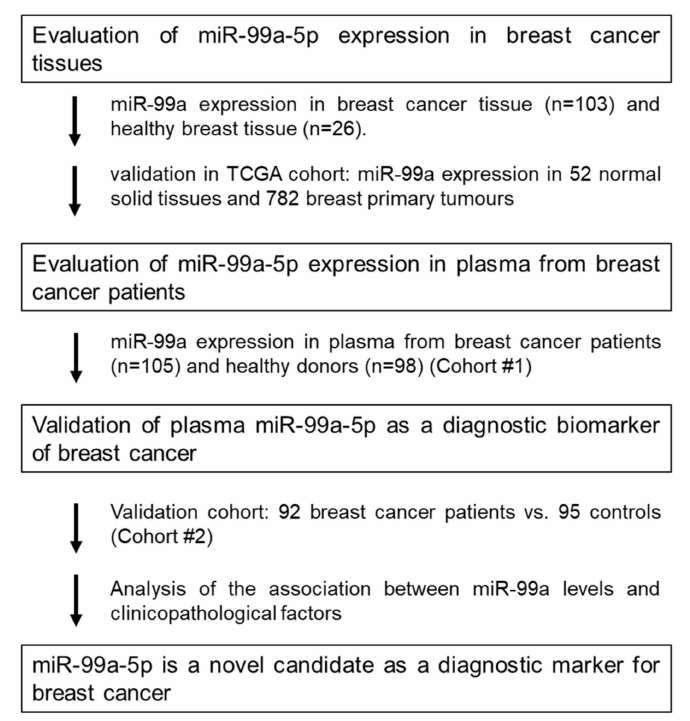
Figure 1. Study design to develop a novel miRNA